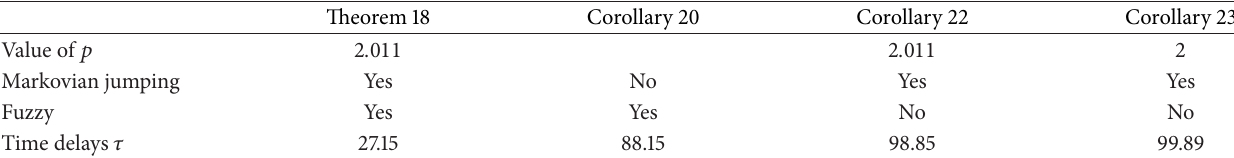
Table 2: Allowable upper bound of 𝜏 for various